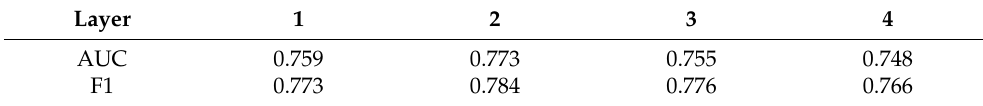
Table 12. The Influence of depth of layer on